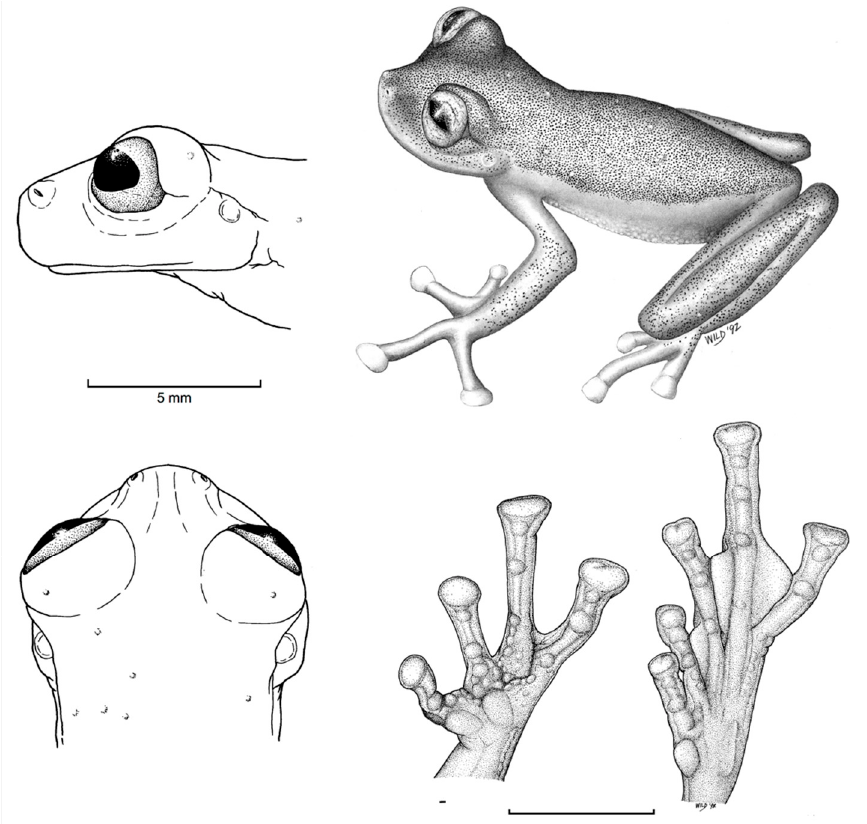
Figure 138. Nymphargus cariticommatus . Drawings of the holotype, adult male, KU 202806. Modified from Wild [137]. Color in life (Figure 137): Dorsal surfaces of head, body, and limbs green with small yellow spots. Dorsal surfaces of fingers and toes yellow. Iris silvery white with black reticulations. Color in ethanol: Dorsum of body and limbs lavender with few, small, scattered white spots (fewer in females). Cheek with pale white flecks; margin of lip unpigmented; tympanum with few